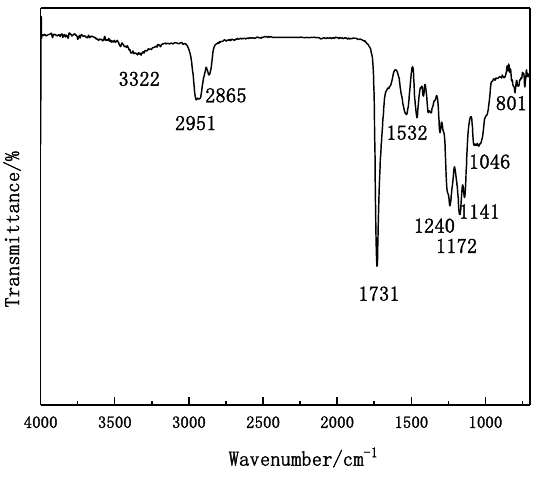
Figure 2. FTIR spectra of WPU-L 1 .